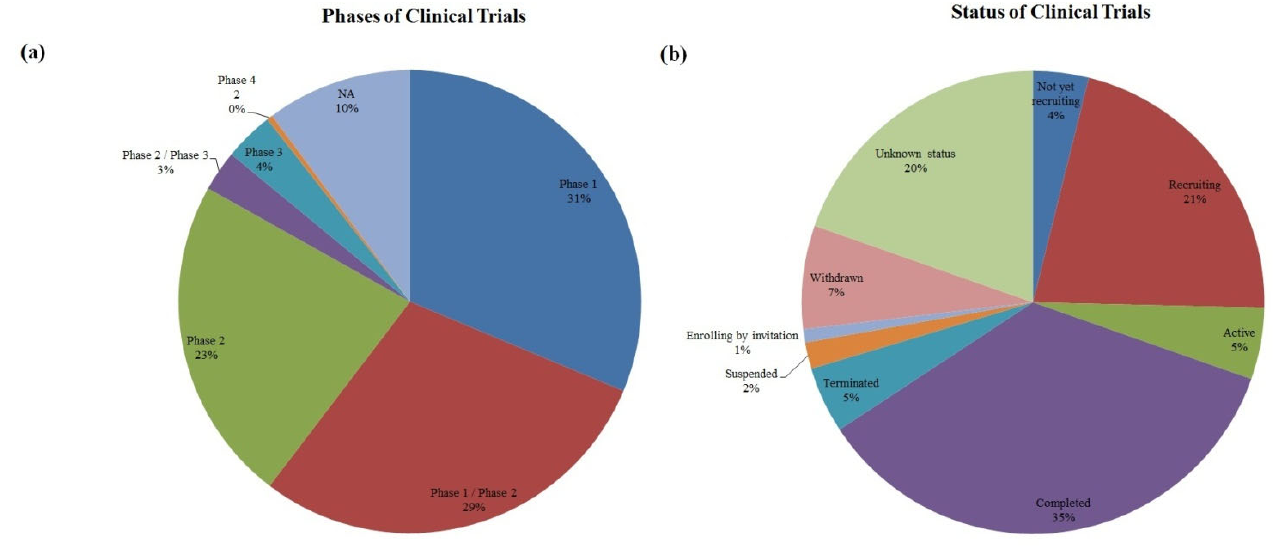
Figure 2. This figure provides a graphical representation of phases and statuses in 492 selected trials. The majority of trials were completed (35%), 21% of trials were recruiting while only 5% were active. We also detected a high percentage of trials with unknown status—20%. 7% of all trials were withdrawn. Phase 1 and phase 2 trials were predominant accounting for 83%. Only 4% of trials were in phase 3 and only 2 trials reached phase 4. ( a ) Represents phases of the clinical trials and ( b ) Represents statuses of the clinical trials, NA—not applicable. Table 1. Clinical trials that have reached phase 4.